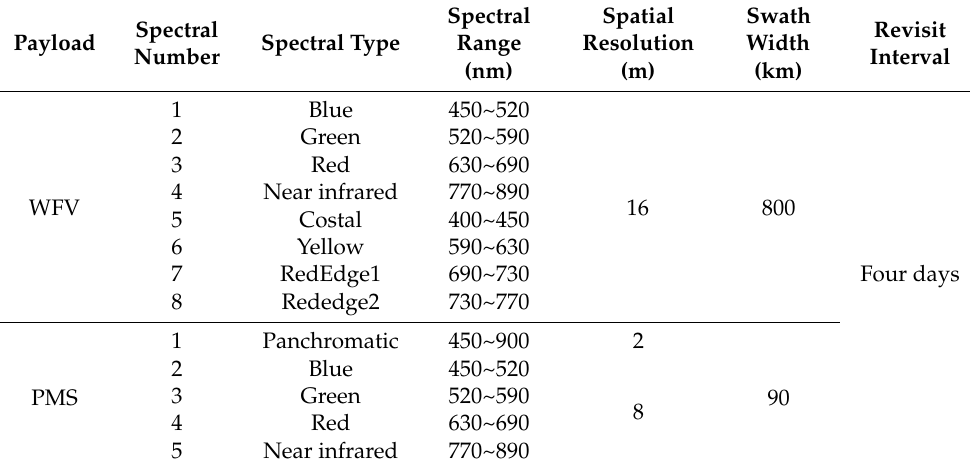
Table 3. Technical parameters of GaoFen-6 (GF-6) (wide field of view (WFV) and panchro- matic/multispectral high-resolution